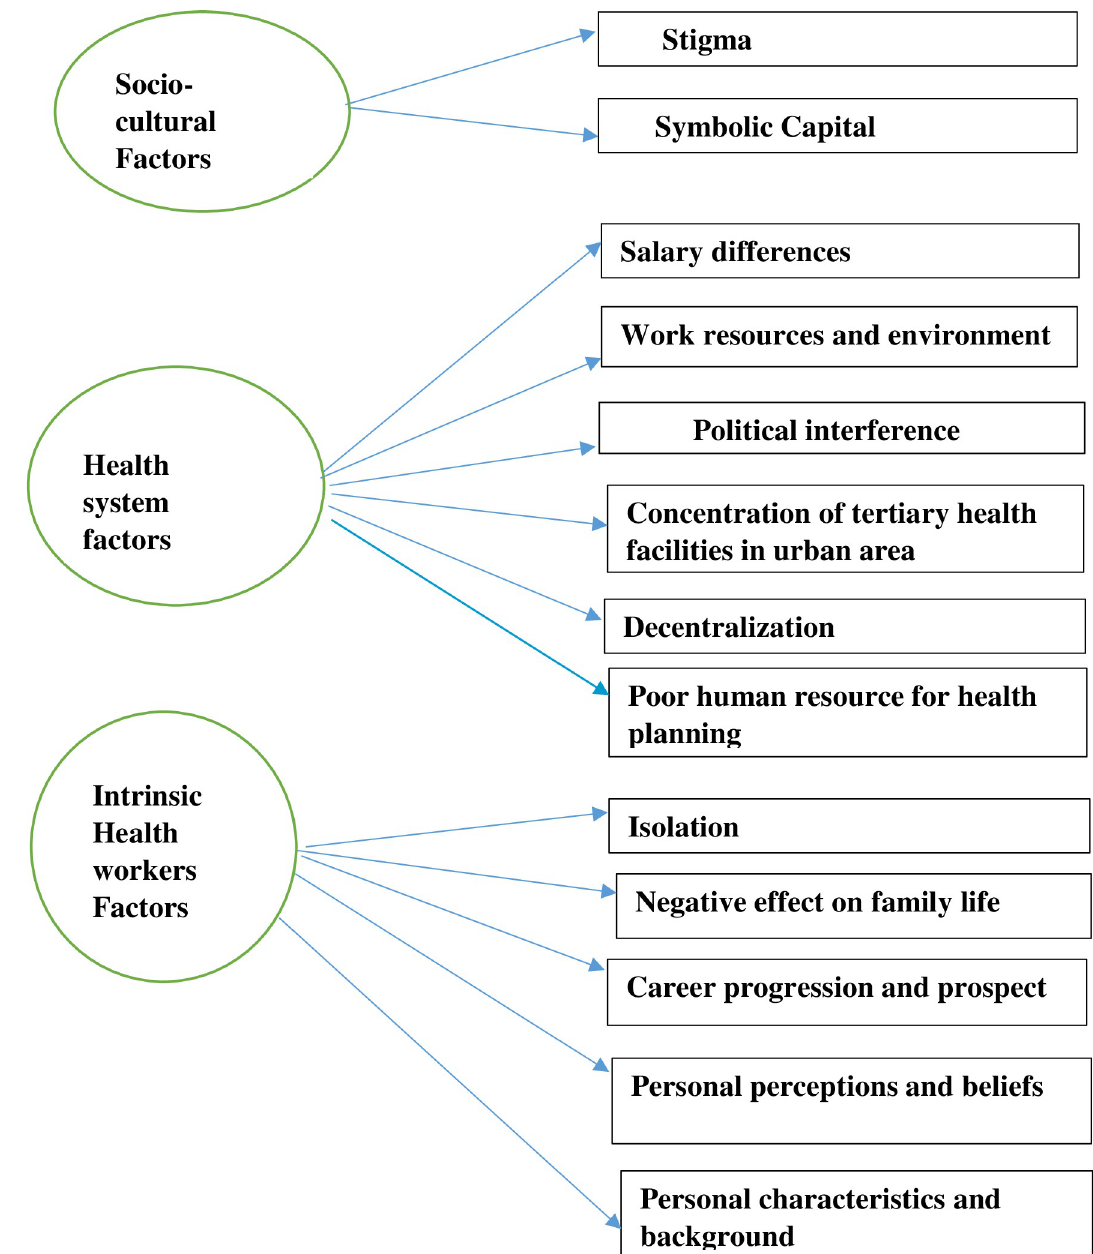
Fig 1. Thematic code for factors affecting the distribution of health workers to rural